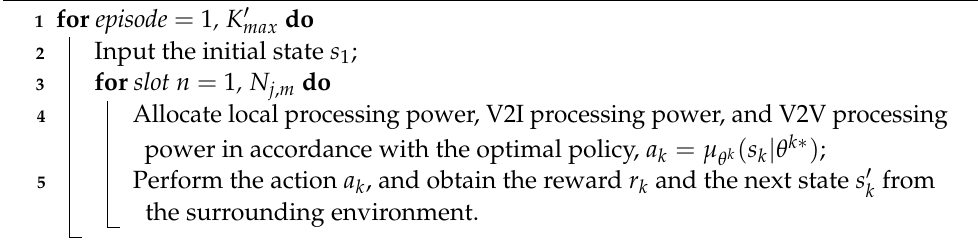
Algorithm 2: Testing stage for the trained